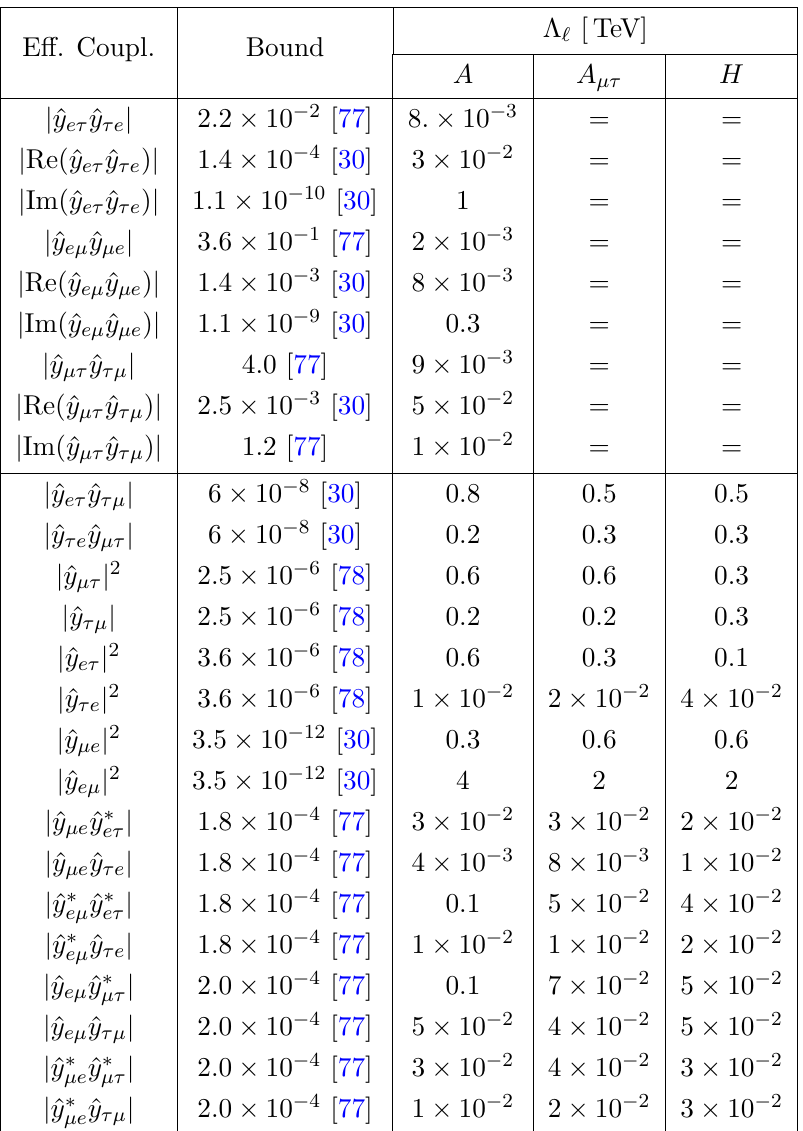
Table 11 . FN lower bounds on the NP cut-off scale Λ ‘ in TeV following from the off-diagonal effective Yukawa couplings in the leptonic sector. Most of the bounds are taken from ref. [77], except those that show explicitly a different reference: in these cases, the experimental bound has improved as compared to the one reported in ref. [77]. The bounds in the first half of the table are independent of the FN charges, while the others are obtained taking (cid:15) = 0 . 23 and with the charge assignments given in table 1. “=” indicates that the bounds in the A µτ and H models are the same as those in the A